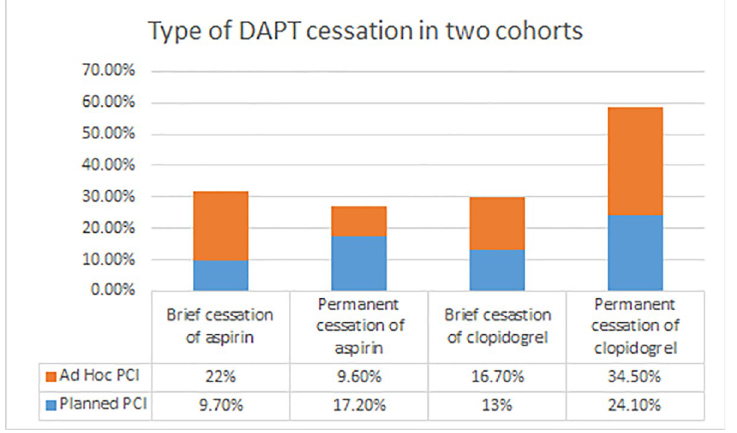
Fig 1. Brief cessation ( < 30days) and permanent cessation ( > 30days) of DAPT in planned PCI and ad hoc PCI cohorts. All four groups have p < 0.05.